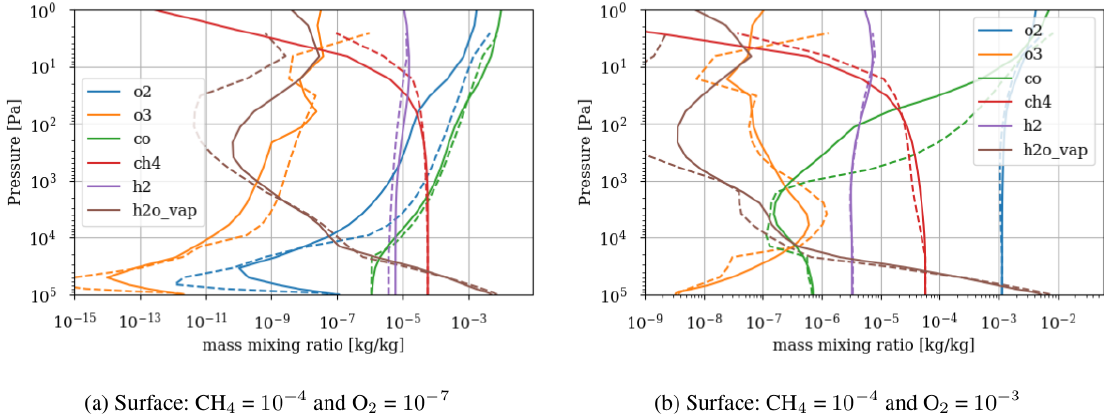
Figure 4. Species profile for 3D surface and annual average (solid) as well as the 1D (dashed) model.